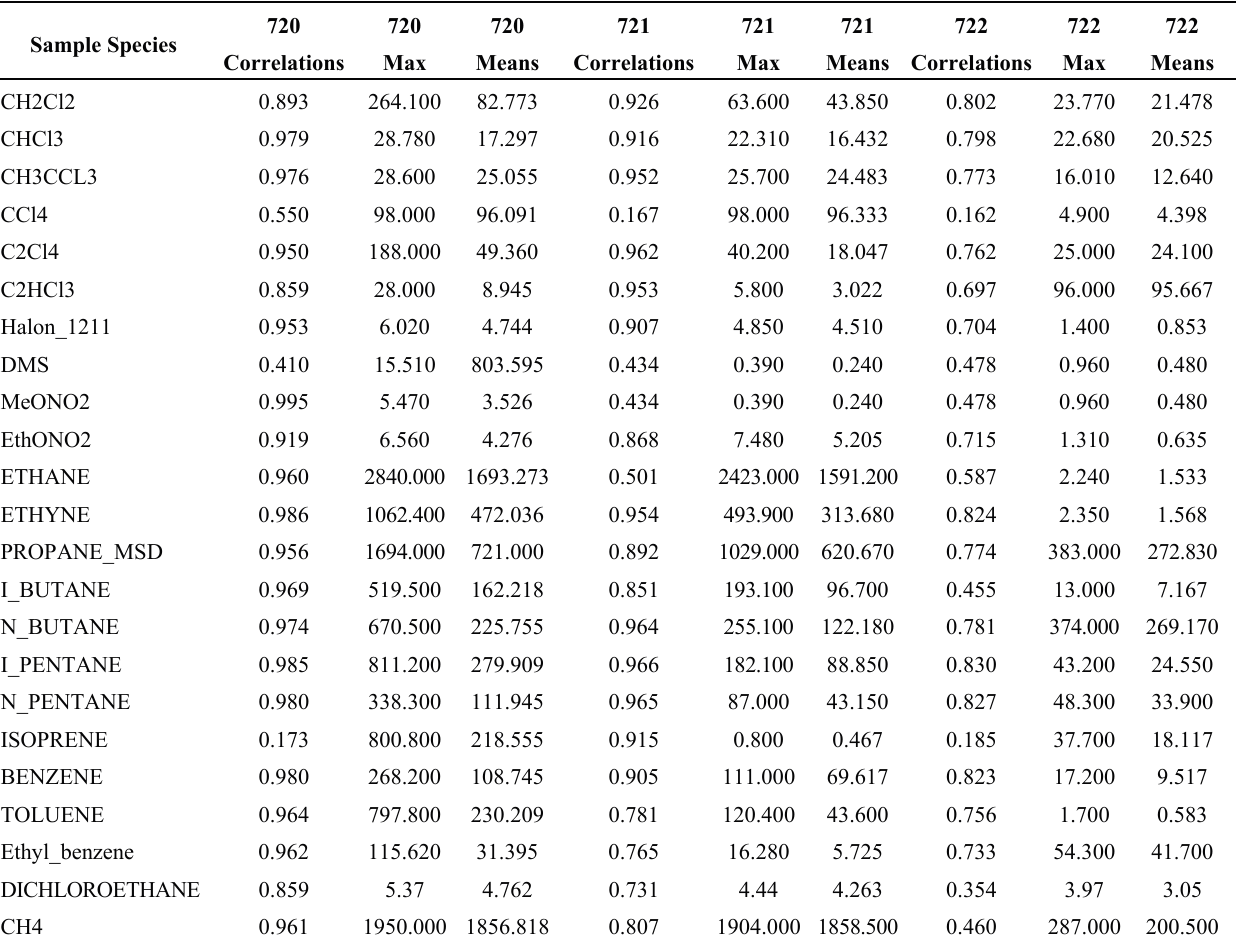
Table 1. Analysis of selected Whole Air Samples taken within the plume layer over NYC on 7/20, as well as over the GOM on 7/21 and 7/22. Included are maximum and mean values for each species, and correlations with CO calculated to the 95% confidence level in each